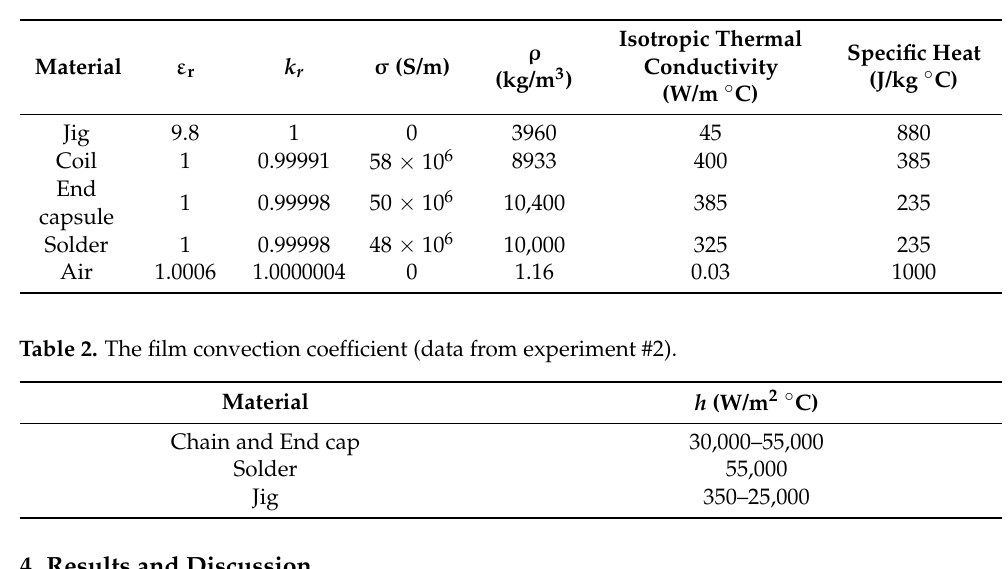
Table 2. The film convection coefficient (data from experiment #2).